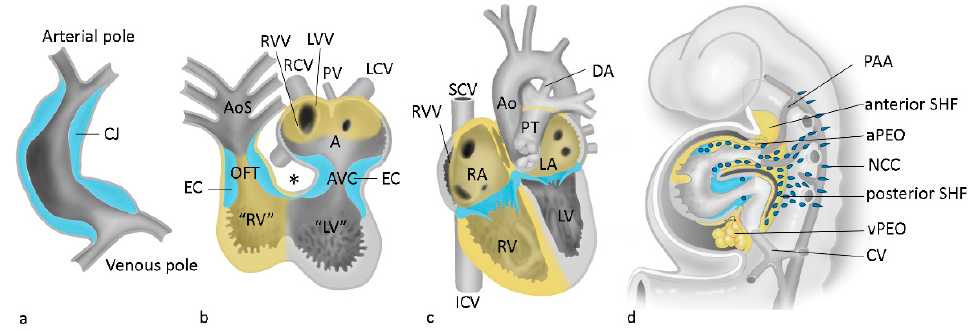
Figure 3. Cardiac development: Contributions from the second heart field and neural crest cells. Panels ( a – c ) reflect successive stages of development. Panel ( d ) represents a lateral view showing the migration path of neural crest cells (NCC). A: common atrium, Ao: aorta, AoS: aortic sac, AVC: atrioventricular canal, CJ: cardiac jelly, CV: cardinal vein, DA: ductus arteriosus, EC: endocardial cushions, ICV: inferior vena cava, LA: left atrium, LCV: left cardinal vein, LV: left ventricle, LVV: left venous valve, NCC: neural crest cells, OFT: outflow tract, PAA: pharyngeal arch artery, PEO: pro-epicardial organ, PT: pulmonary trunk, PV: pulmonary vein, RA: right atrium, RCV: right cardinal vein, RV: right ventricle, RVV: right venous valve, SCV: superior vena cava, SHF: second heart field. * inner curvature of the looping heart. Derived with permission from Gittenberger-de Groot et al. [4].